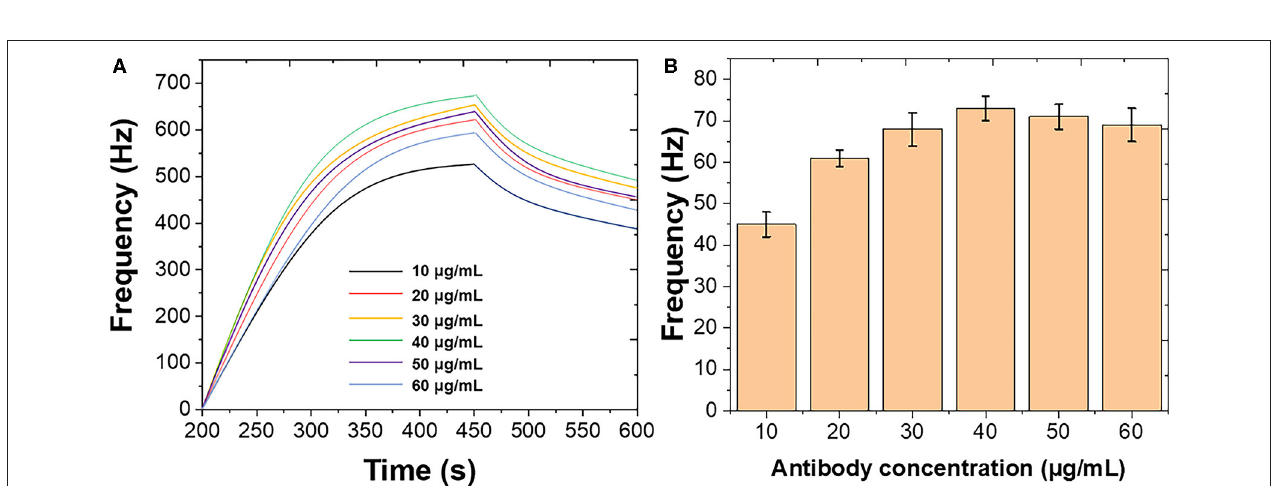
FIGURE 1 | (A) Frequencies recorded at QCM when different concentrations of polyclonal antibody immobilized on the Au chip surface. (B) Frequencies performance of QCM after introduction of B. bifidum after the immobilization of different concentrations of polyclonal antibody.